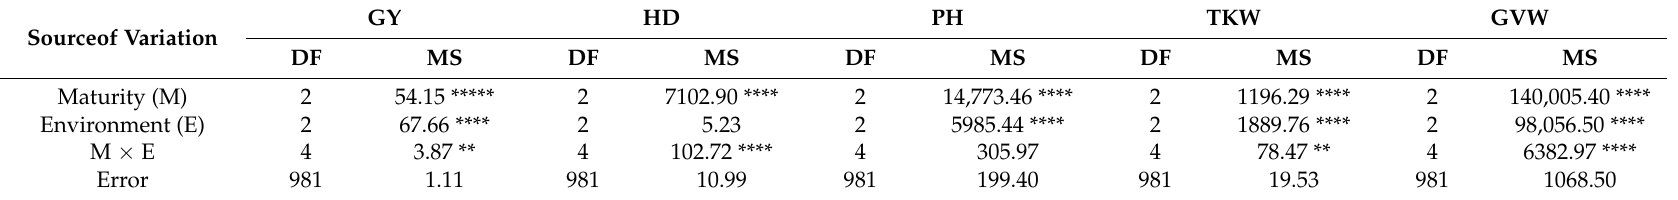
Table 2. The analysis of variance (ANOVA) on the three maturity groups for each trait across the three environments.